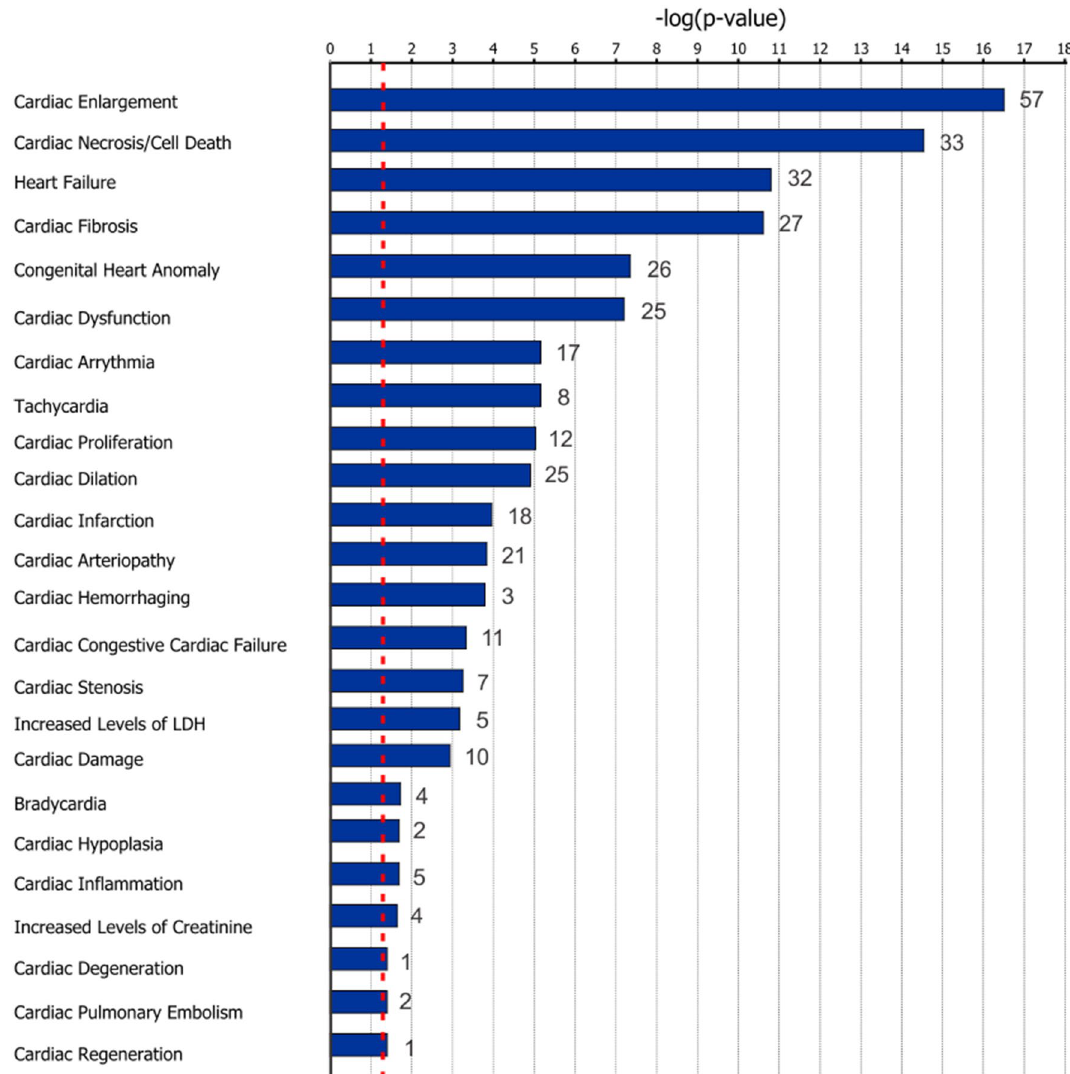
Figure 6. Cardiac diseases related to mRNAs predicted to be targets of altered miRs in HF human SAN. Numbers after each bar indicate the total IPA-predicted mRNA targets of significantly altered miRs (P < 0.05) involved in each disease. The graph was generated with IPA (Winter Release December 2019, Qiagen). HF indicates heart failure; LDH, lactate dehydrogenase; SAN, sinoatrial